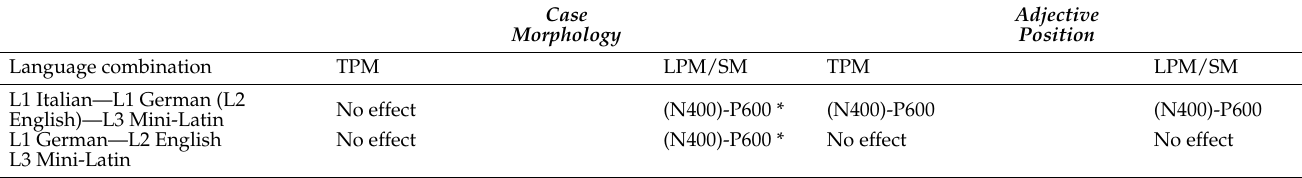
Table 1. ERP predictions for the processing of case morphology and adjectival position violations in Mini-Latin by adult HSs of Italian in Germany (2 L1s—Italian and German) and L1 German–L2 English late L2ers, derived from the TPM, LPM and SM (see also